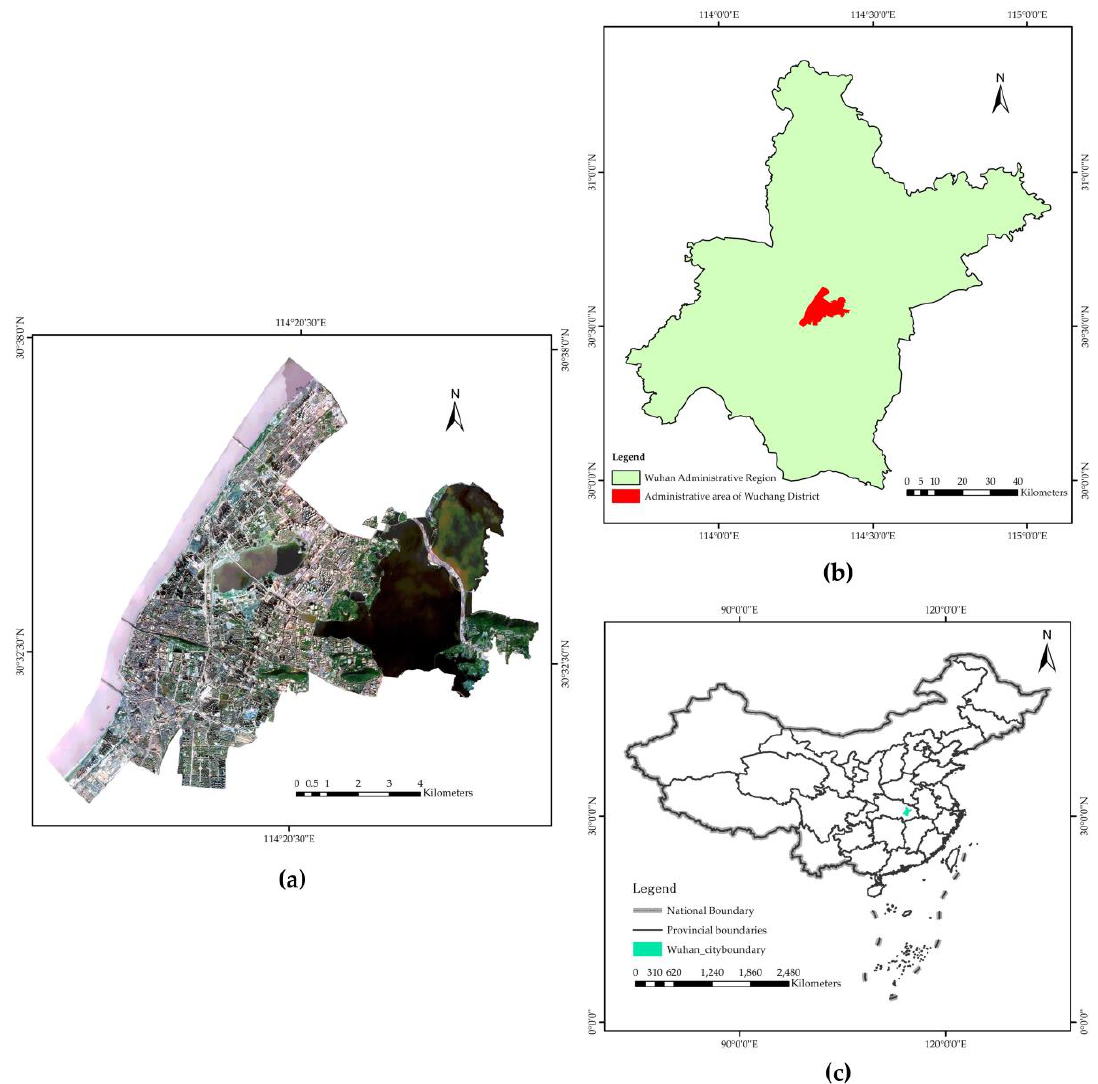
Figure 1. ( a ) The preprocessed satellite high-spatial-resolution remote sensing imagery of the study area; ( b ) the location of the study area in Wuhan; ( c ) the location of Wuhan in China.